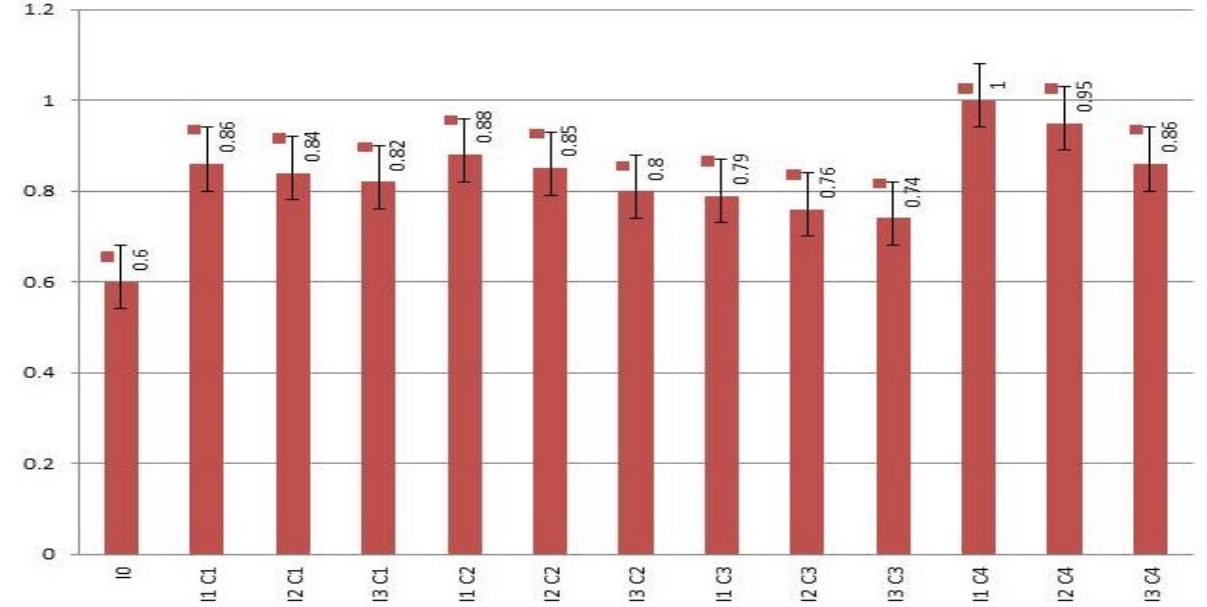
Figure 8. Semiquantitative gene expression through Rt-PCR of gene POTT and MdNPFr6.5.